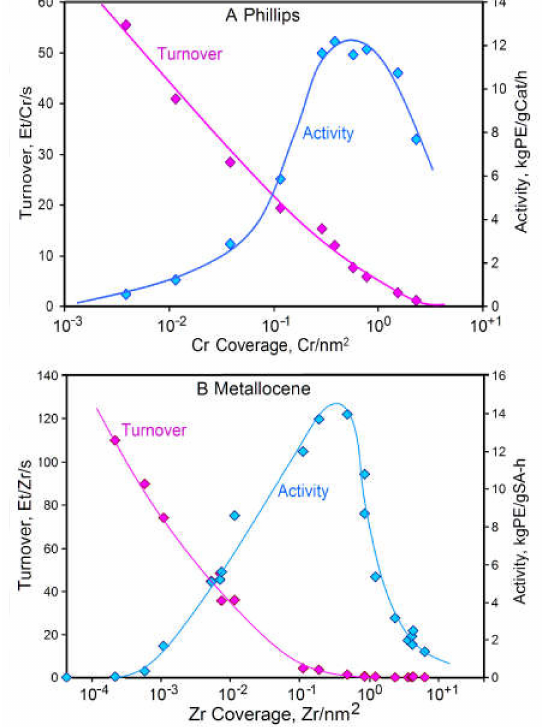
Figure 2. Overall activity and metal turnover for Phillips (( A ), above) and metallocene (( B ), below) catalysts as a function of metal